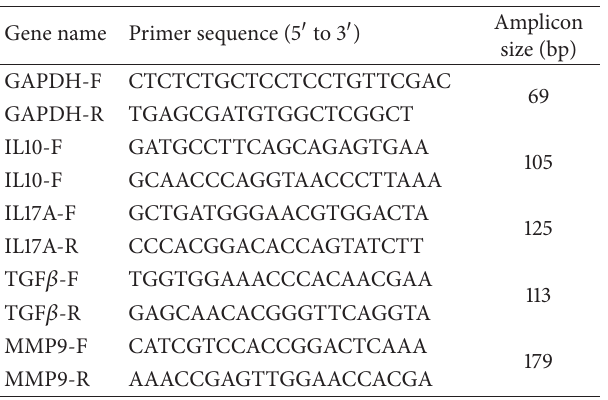
Table 1: Primer sequences and amplicon